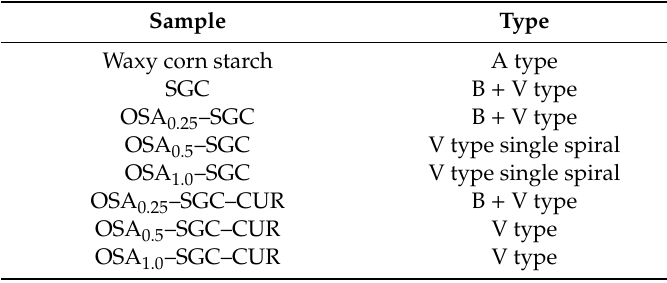
Table 5. The effect of OSA and curcumin encapsulation on the crystalline type of SGC. Table 5. The e ff ect of OSA and curcumin encapsulation on the crystalline type of SGC.